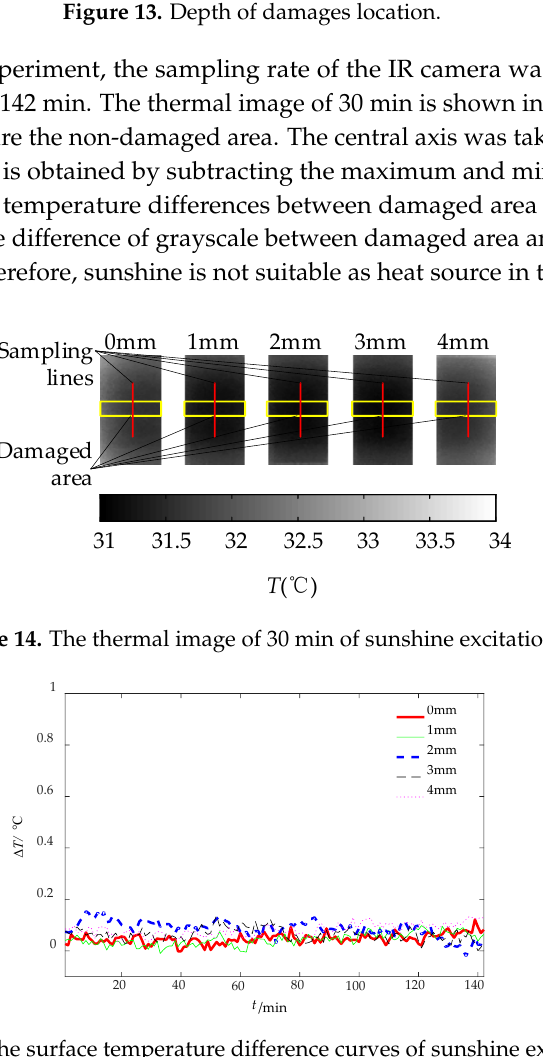
Figure 15. The surface temperature difference curves of sunshine excitation.